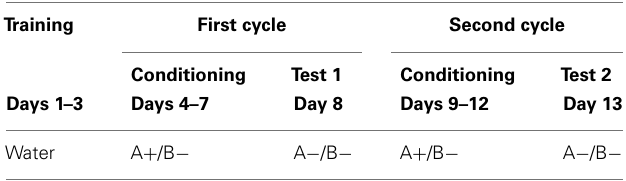
Table 1 | Design table of conditioned flavor preference during training and testing.